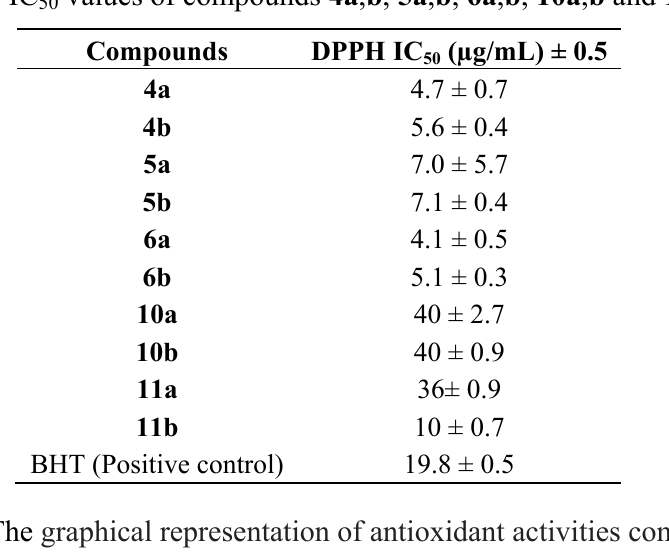
values of compounds 4a , b , 5a , b , 6a , b , 10a , b and 11a , b . Table 1. IC 50